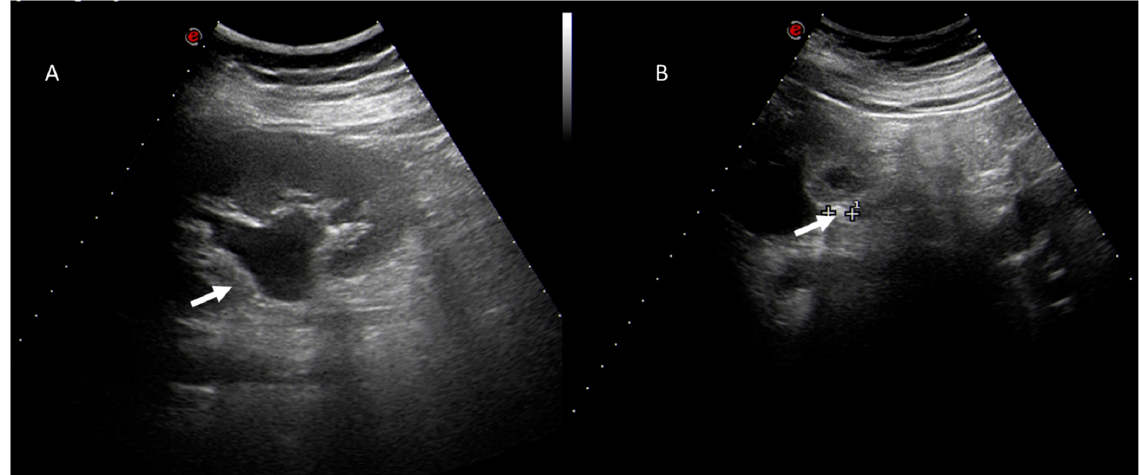
Figure 3. Pregnant woman with left flank pain. US assessment ( A , B ) shows hydroureteronephrosis (arrow) in ( A ) and distal ureteral calculi (arrow) in ( B ). Acute pyelonephritis (APN) is a severe urinary infection (Figure 4) that can cause sepsis, shock, and death. Pregnancy increases the risk of complications from APN.